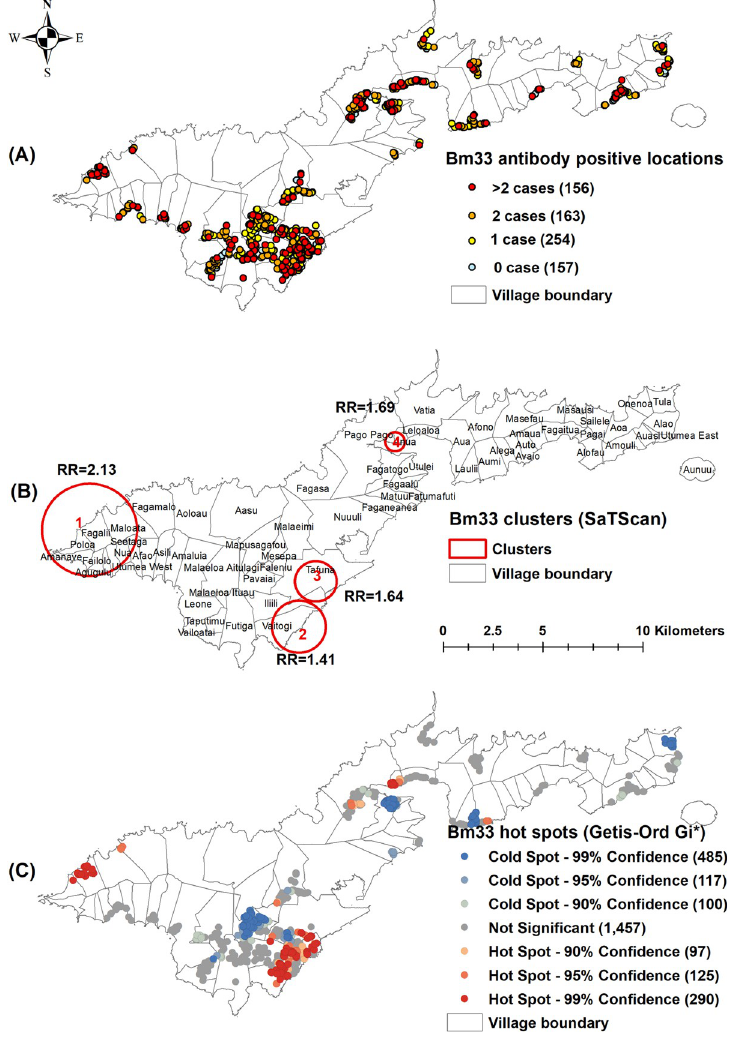
Fig 6. A) Spatial distribution of Bm33 antibody in survey locations, B) Spatial clusters of antibody positive survey locations (SaTScan), C) Hotspots of antibody positive survey locations (Getis-Ord Gi � ), American Samoa 2016. Base layers from (https://www.diva-gis.org/Data).